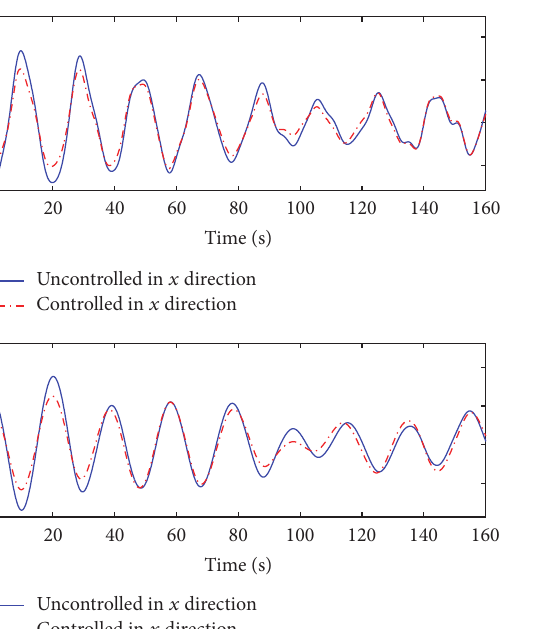
dampers can effectively decrease the structural displacement under wind load, especially the top displacement of the tower.